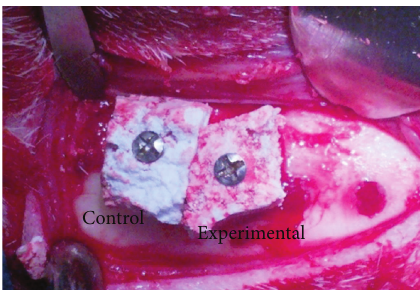
Figure 2: Clinical aspect of extraoral access utilized for the placement of control and experimental blocks. Blood wetting was observed throughout the volume of the experimental block material, whereas blood wetting was lower for the control